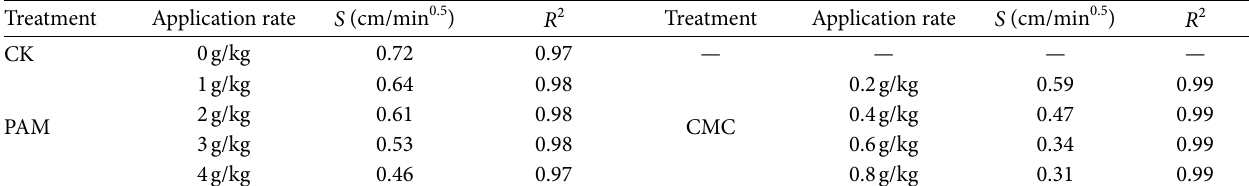
(Table 1). The mean values of 𝑎 for PAM treatments (1.763)